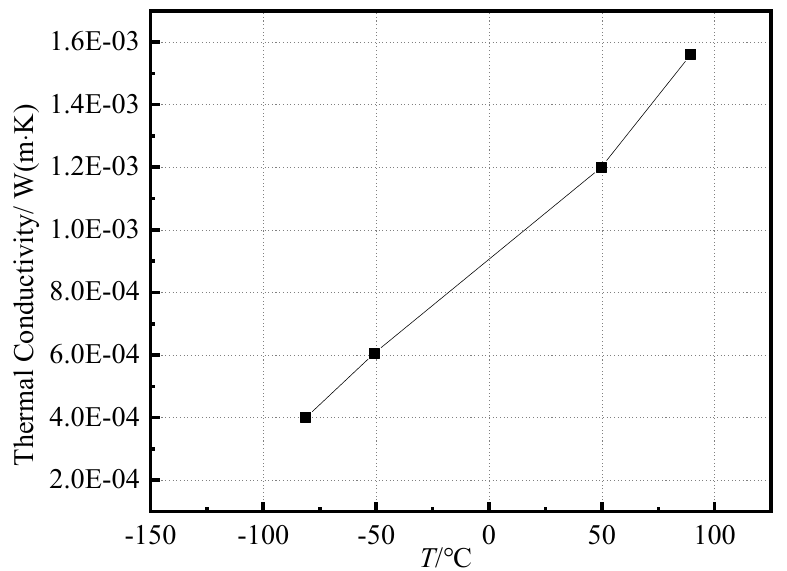
Figure 10. Thermal conductivity of the new material (temperature difference of 30 K, compression thickness of 2 mm, and vacuum of about a 0.001 Pa magnitude).